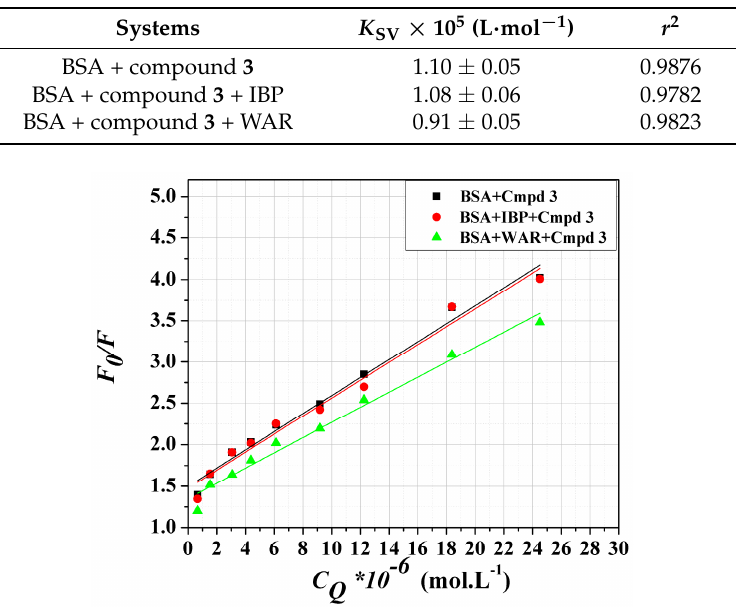
Table 4. Binding constant of compound 3 with the co-solution of BSA and site markers.